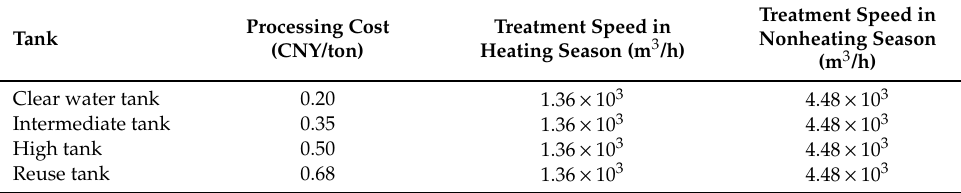
Table 4. Process index of mine water reuse treatment.